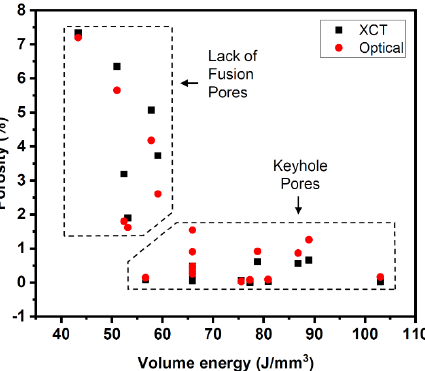
Figure 7. Comparison of porosity measured using XCT and optical microscope.